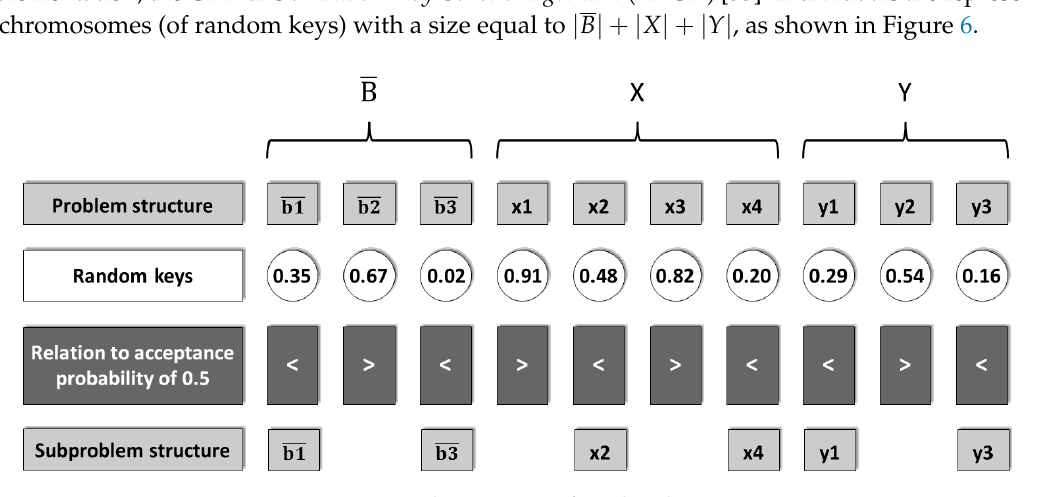
Figure 6. Chromosome of random